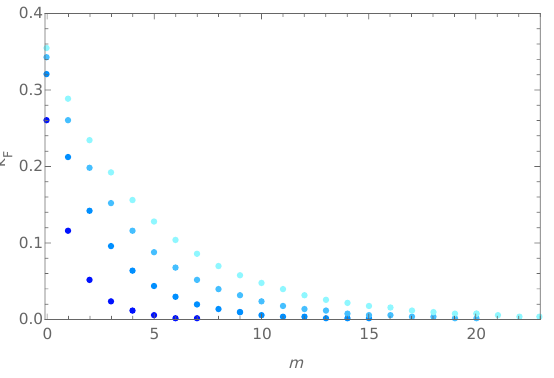
Figure 4 . The Fermi momenta are plotted in terms of m for different values of γ = 100 , 150 , 200 , 250 from bottom to top. For each value of γ there exists a maximum value of the Fermi